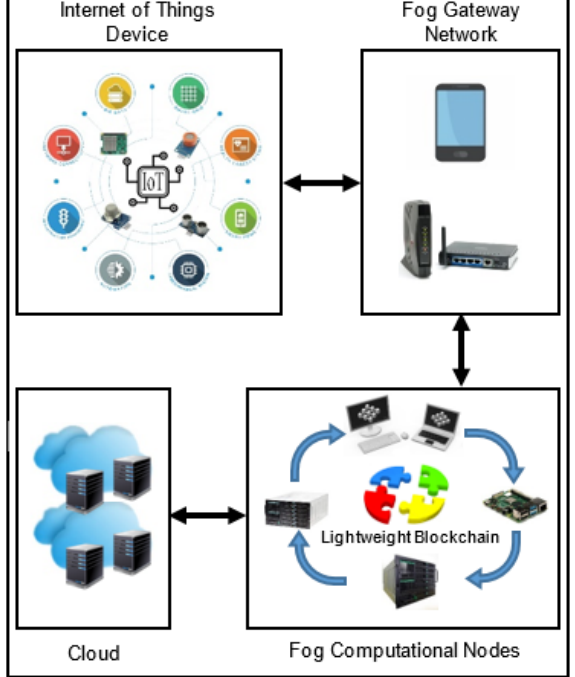
Fig. 1. Lightweight Blockchain Framework Scheme posed in this lightweight blockchain does not change